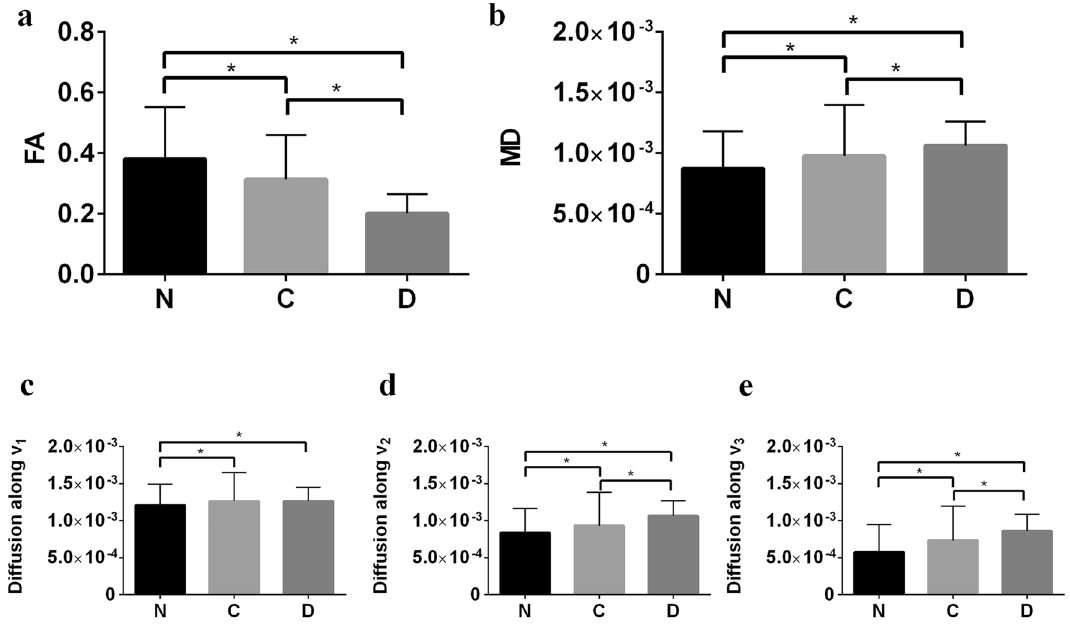
Figure 3. Quantification of tissue heterogeneity using DTI based indices. The derived indices are displayed as columns (mean) for each ROI. Three native tissue (N) samples, three collagenase treated tissue (C) samples and three decellularized tissue (D) samples were used for comparison. (n = 12, one ROI per slice, 4 slices per sample). ( a ) Fractional anisotropy (FA), ( b ) mean diffusivity (MD), ( c ) diffusion along V 1 , ( d ) diffusion along V 2 and ( e ) diffusion along V 3 . Values represent mean ± SD. * p < 0.05. HMb protocol was used to calculate the DTI derived indices.